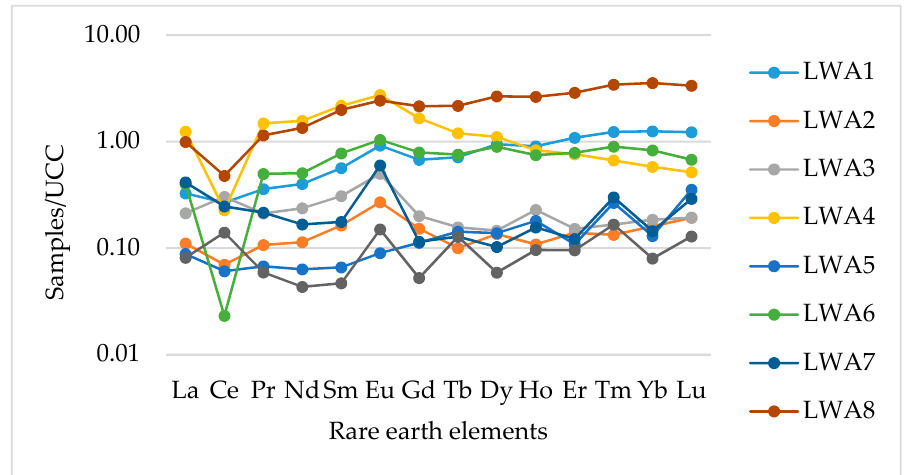
Figure 5. Rare earth element plot of the clay size fraction of the Lwamondo kaolin samples compared to the UCC.